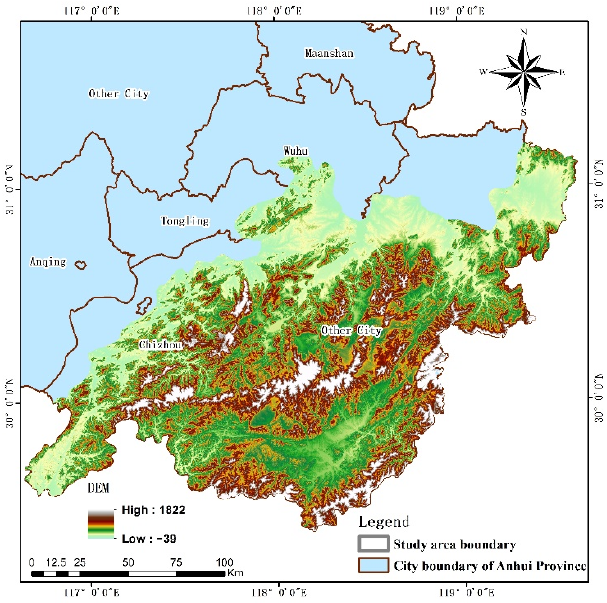
Figure 6. The location of the SAHMHER in Anhui Province.